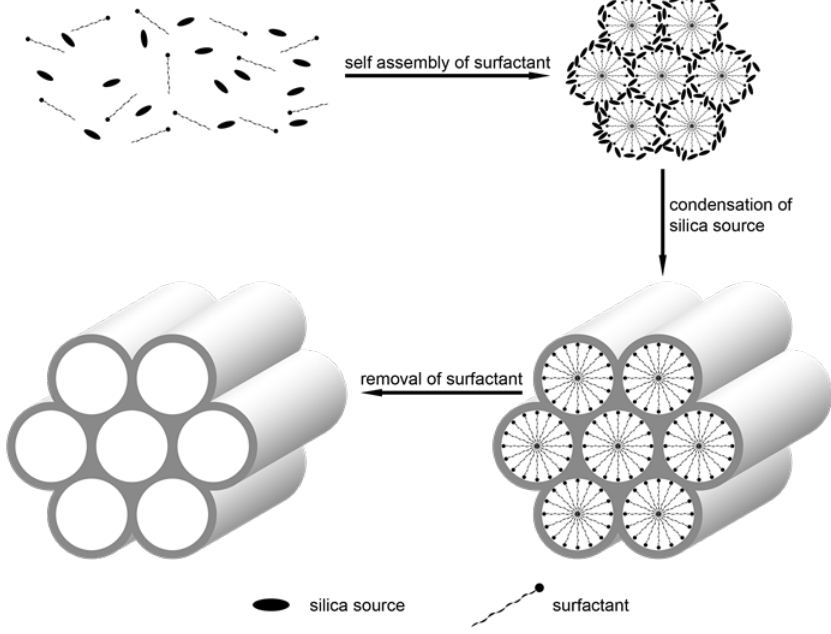
Figure 1. Simple procedure synthesis of mesoporous silica nanoparticles.